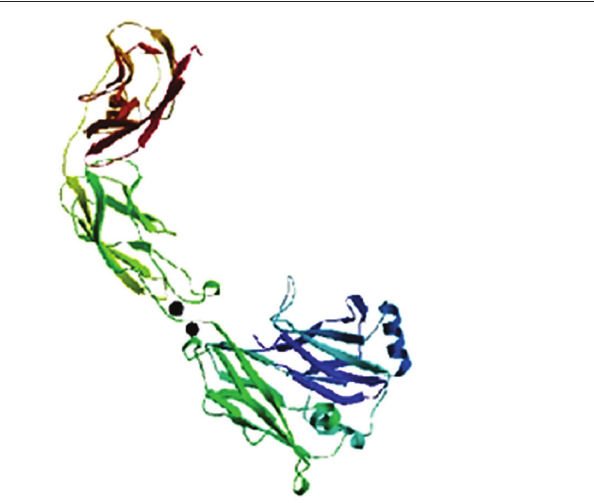
figurE 2 − Homology model of the RET proto-oncogene [ Homo sapiens ]